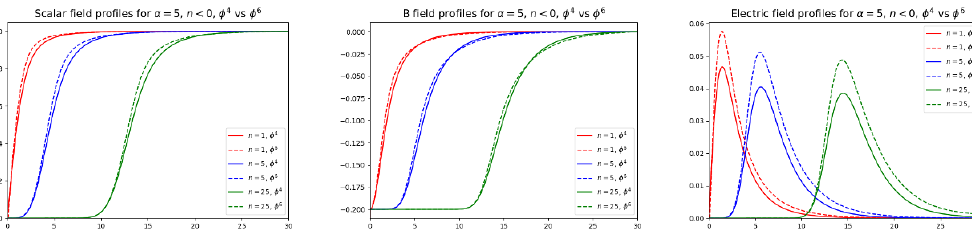
Figure 10 . Vortex pro(cid:12)les with negative winding number for quartic(solid) and sextic(dashed)